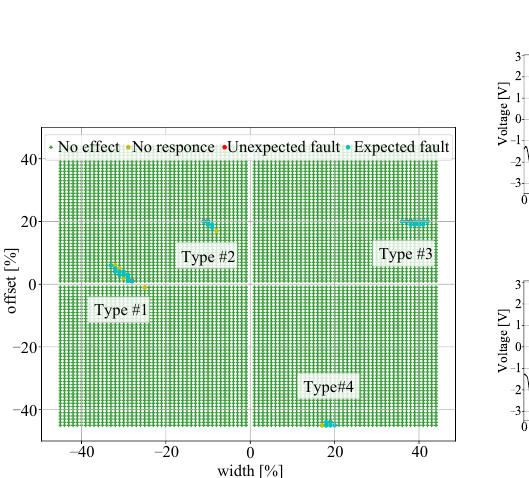
Figure 18: Successful glitches: (a) width=- 32, offset=6, (b) width=-10, offset=20, (c) width=41, offset=21, (d) width=19, offset=-45. The clock signal split into two at the central position is a